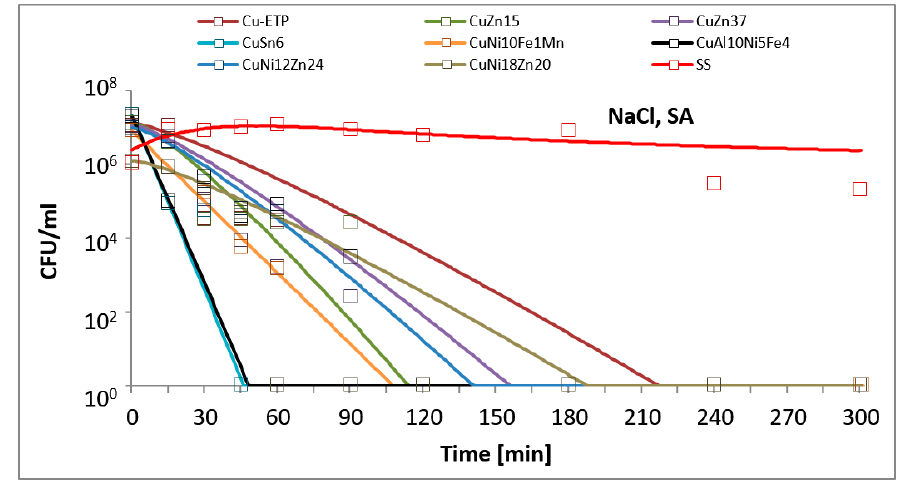
Figure 4. Staphylococcus aureus (SA) suspension density (CFU/mL) reduction on tested metallic materials, in the variant of the experiment simulating lack of organic contamination.